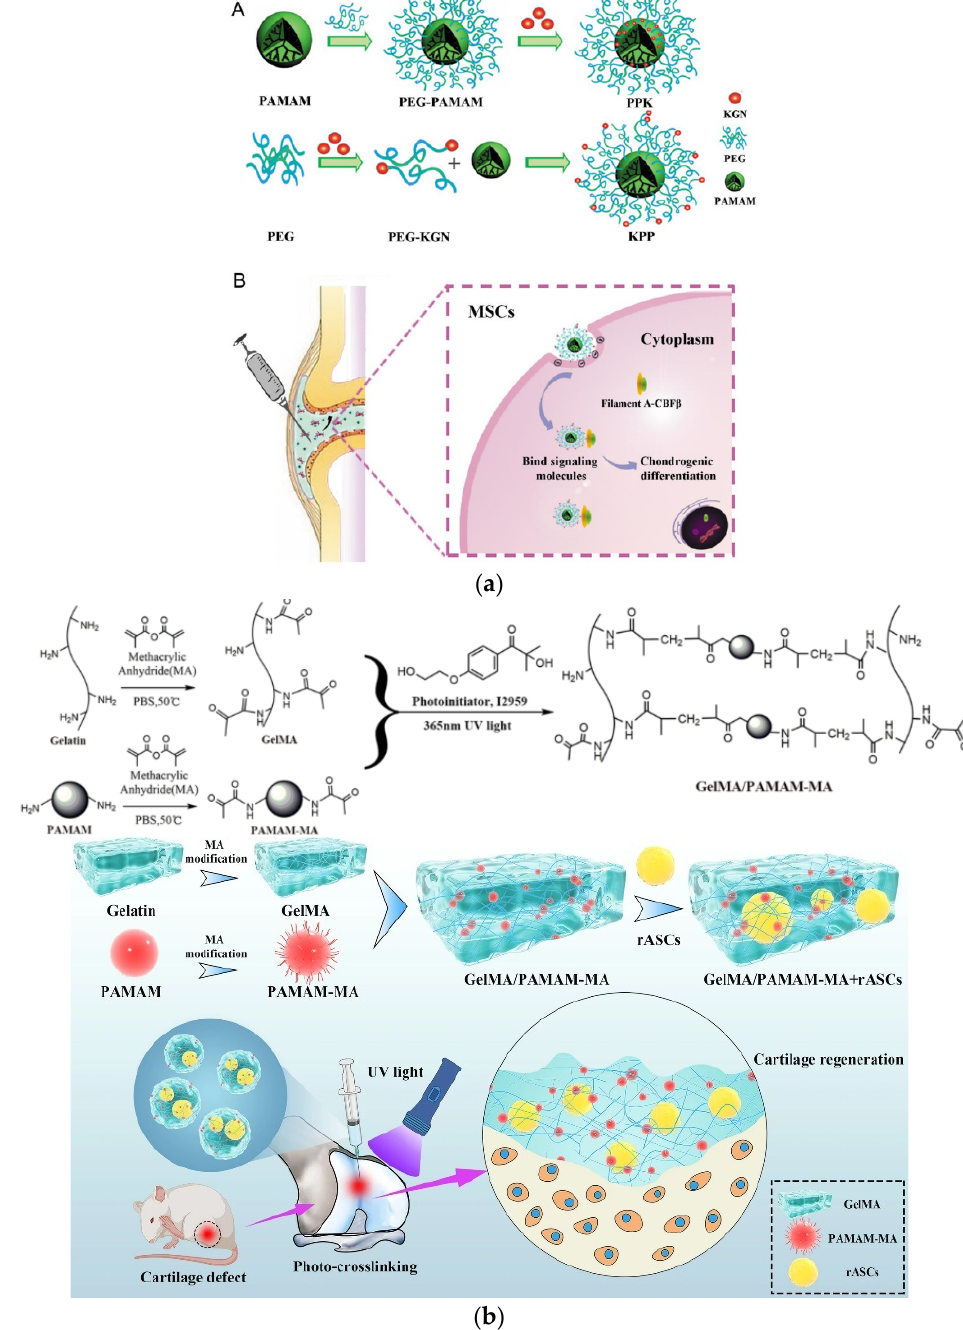
Figure 34. ( a ) Schematic illustrations of construction ( A ) and chondrogenic differentiation effect ( B ) of KGN-PAMAM conjugates. Through IA injection, KGN-PAMAM conjugates with positive charge were taken up by the mesenchymal cells via adsorptive endocytosis and then delivered to the cytoplasm where KGN competitively interacted with signaling molecules and thus